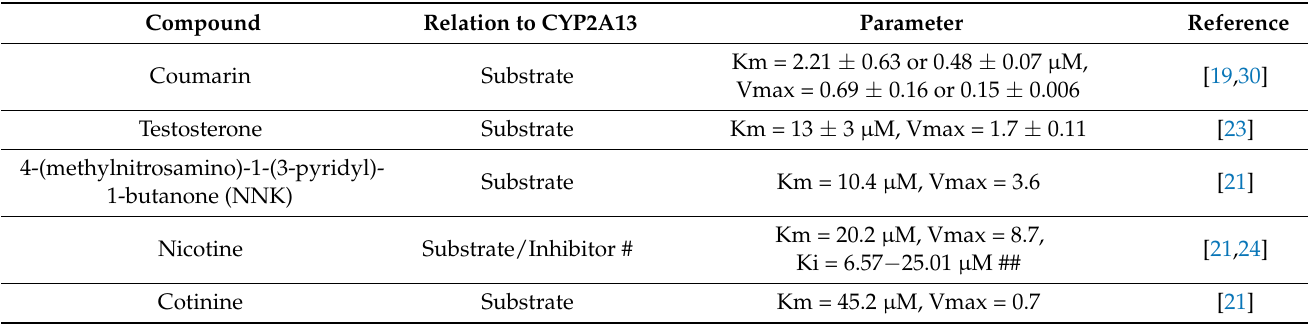
Table 1. Selected substrates and inhibitors of